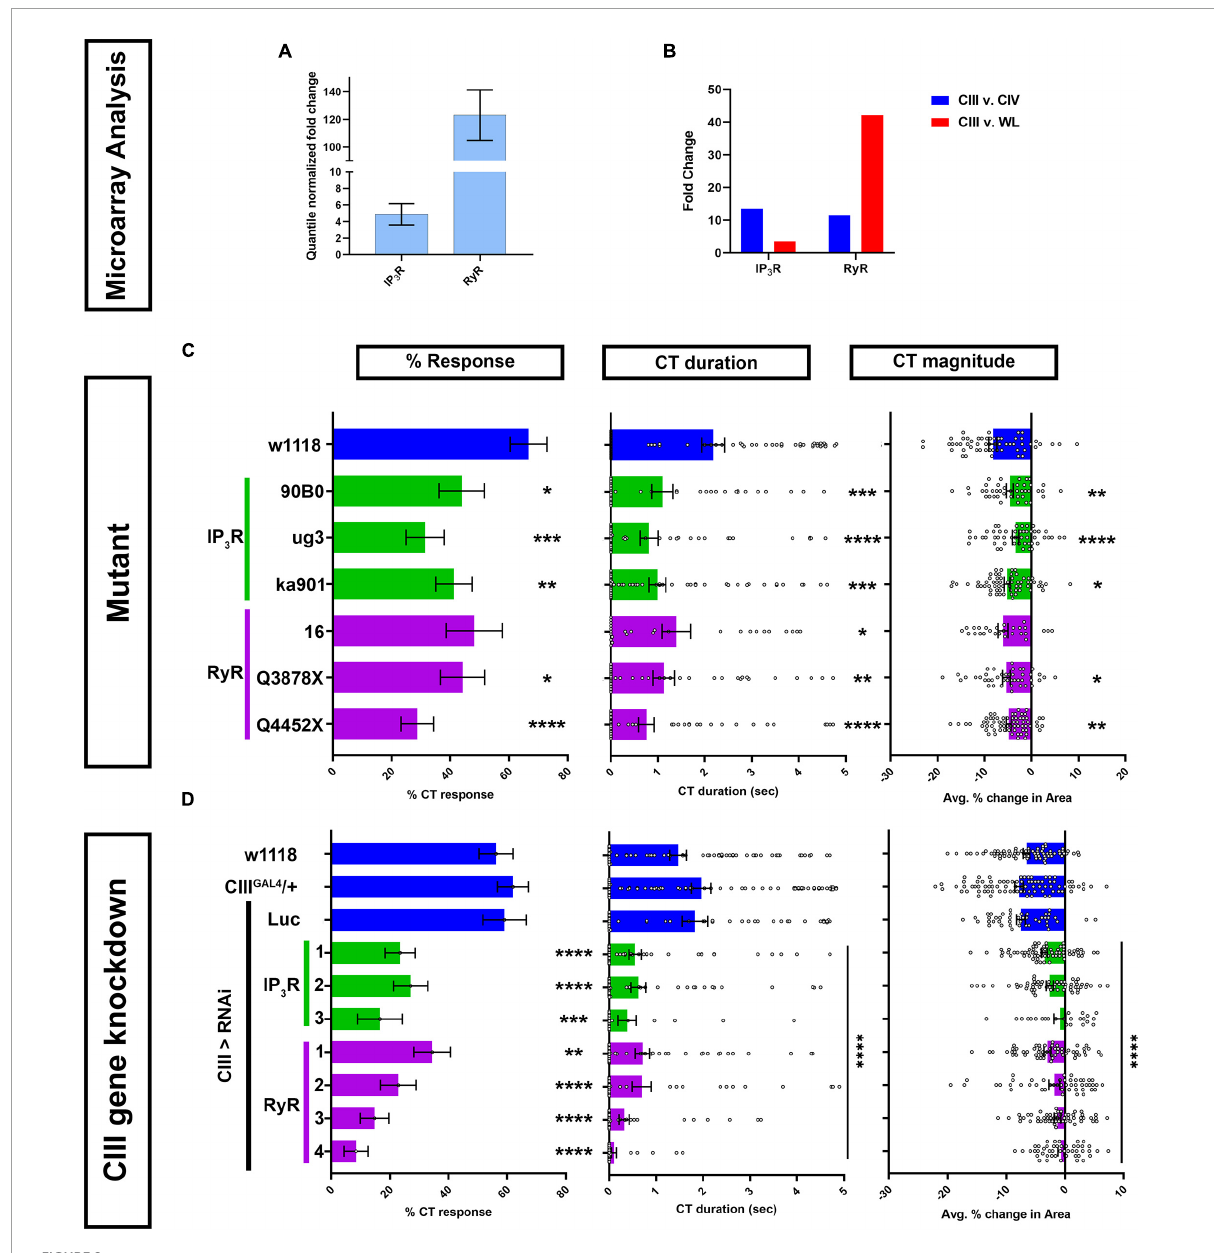
FIGURE2 Calcium induced Ca 2 + release genes IP 3 and ryanodine receptors are required for cold-evoked behaviors. (A,B) Transcriptomic analysis using microarray datasets. (A) Quantile normalized expression of RyR and IP 3 R in CIII md neurons. (B) Comparative analysis of IP 3 R and RyR expression between CIII md neurons and CIV md neuron or whole larva (WL). (C,D) Cold plate analysis of RyR and IP 3 R. (C) Drosophila larvae heterozygous mutants for either IP 3 R ( ug3 , ka901 , and 90B0 alleles) or RyR ( 16 , Q3878X , and Y4452X alleles). All statistical comparisons were made to w1118 . N Average = 49. We report %CT (left), CT duration in seconds (middle), CT magnitude (right). (D) IP 3 R or RyR knockdown specifically in CIII md neurons using 19–12 GAL 4 driver. Control conditions include: w1118 , 19–12 GAL 4 /+ , and 19–12 > Luc RNAi . We report %CT (left), CT duration in seconds (middle), CT magnitude (right). There is no statistical difference between the controls. Knockdown of RyR and IP 3 R was tested using multiple independent RNAi lines and comparisons made to 19–12 GAL 4 /+. N Average = 55. Significant differences indicated via asterisks, where * p < 0.05, ** p < 0.01, *** p < 0.001, and **** p < 0.0001.